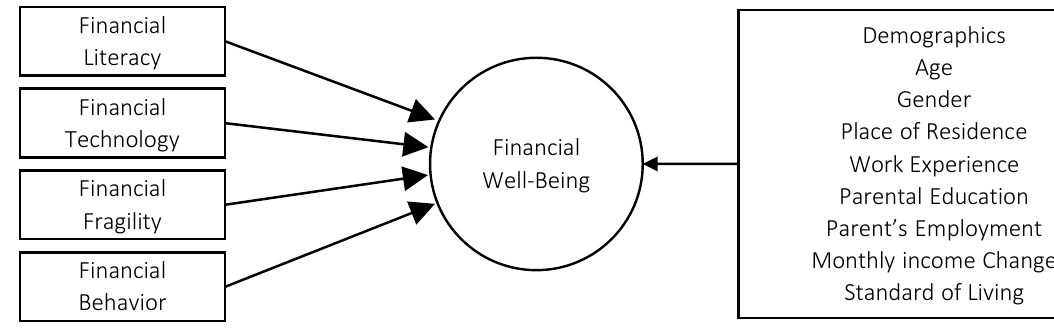
Figure 1. Conceptual